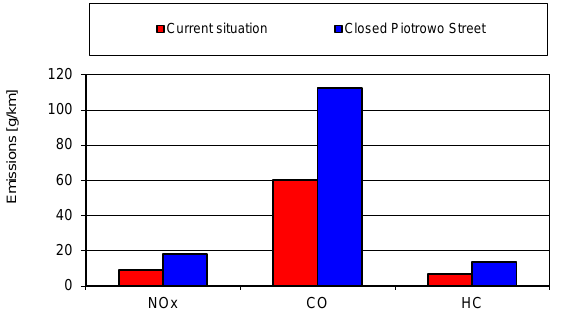
Fig. 8. Emissions of vehicles in the afternoon peak on the St. Roch bridge